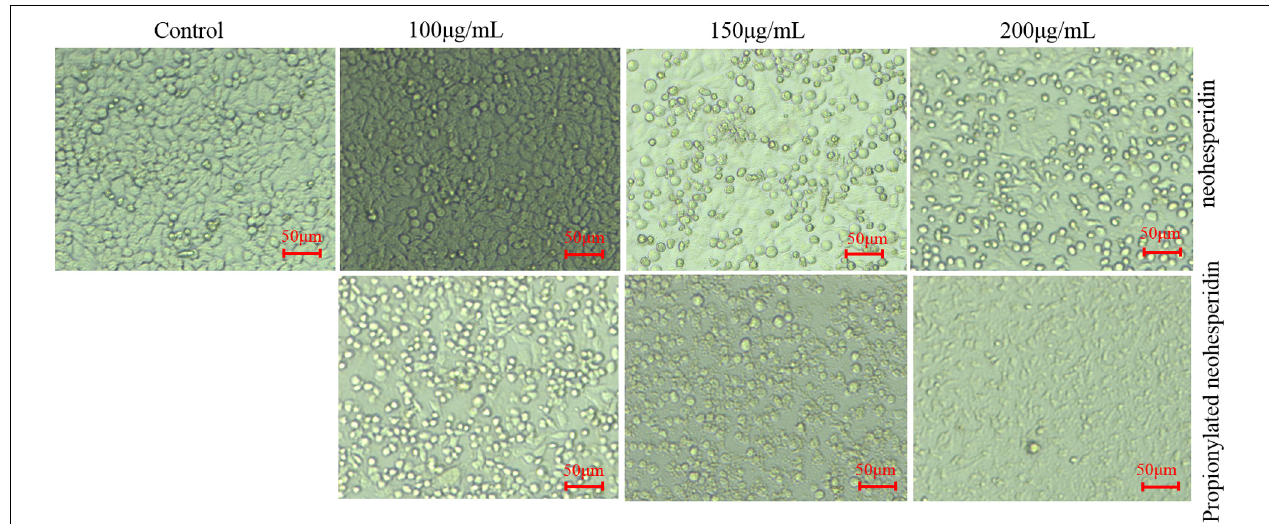
FIGURE 6 | The morphological effect of NH and PNHE on MCF-7 cells. Scale bar = 50 µ m. All images shown are representative of three independent experiments.